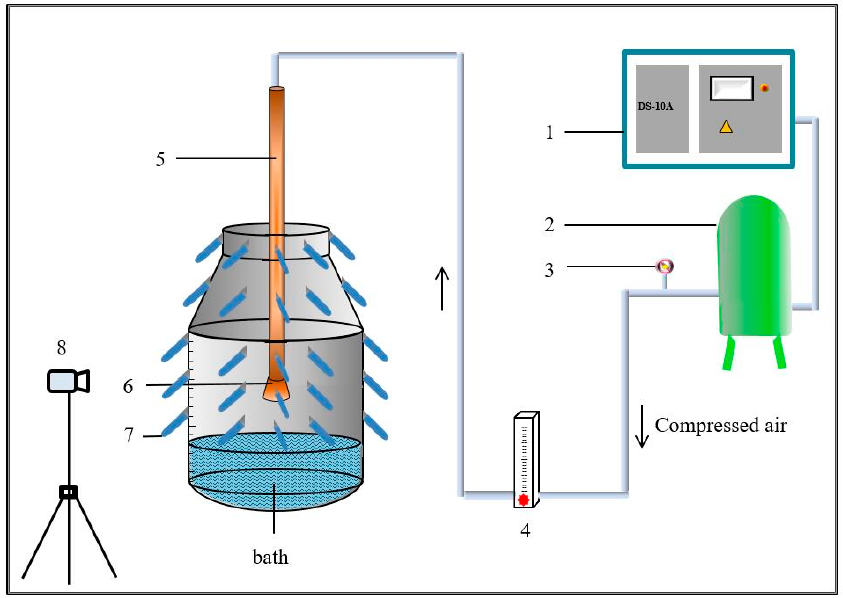
Figure 1. Schematic diagram of the experimental equipment (1—air compressor; 2—gas